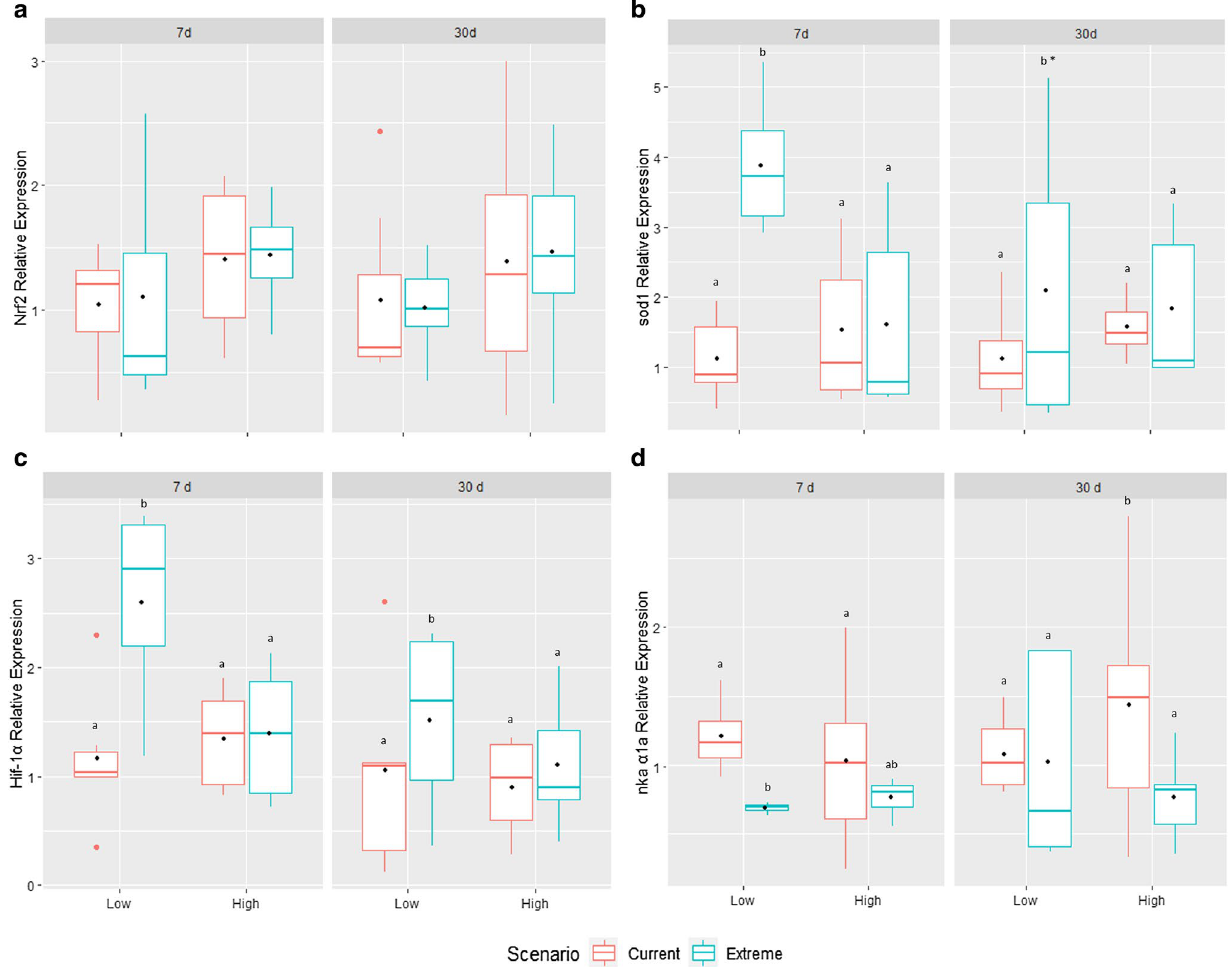
Figure 3. Gene expression of NRF2 ( a ), SOD1 ( b ), HIF-1α ( c ) and NKA α1a ( d ) in the gills of Colossoma macropomum exposed to the extreme climate scenario as foreseen by IPCC (2014), compared to current scenario. Boxes with different letters indicate differences between scenarios and asterisks indicate differences between exposure periods ( p < 0.05). Low (LG) and High (HG) indicate the degree of parasitism after seven and thirty days of exposure to the experimental conditions. A black dot in the box indicates the average of each